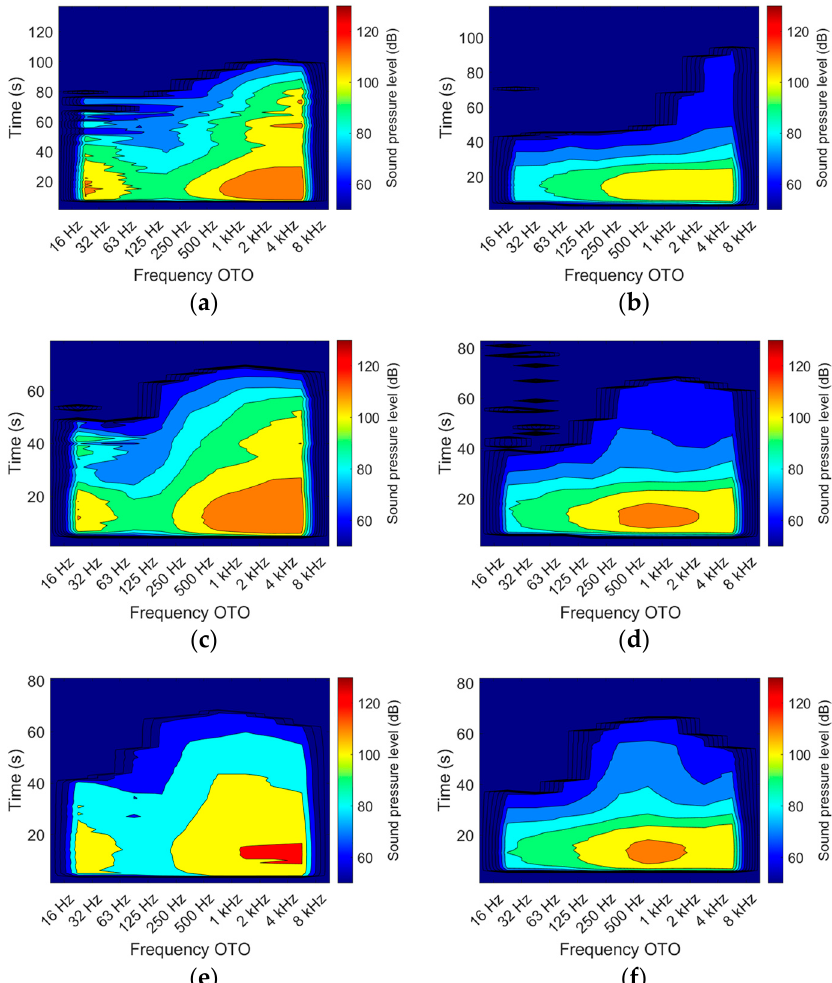
Figure 8. SPL as a function of time and OTO (One-Third Octave bands) frequency throughout a nitrogen IG100 discharge by ( a ) standard and ( b ) silent nozzle with 10 mm orifice diameter; ( c ) standard and ( d ) silent nozzle with 17 mm orifice diameter; ( e ) standard and ( f ) silent nozzle with 23 mm orifice diameter.